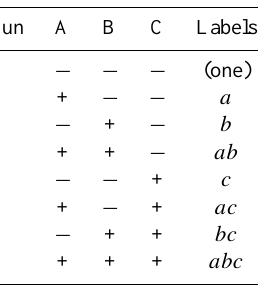
Table 1. Design matrix for the general 2 3 factorial